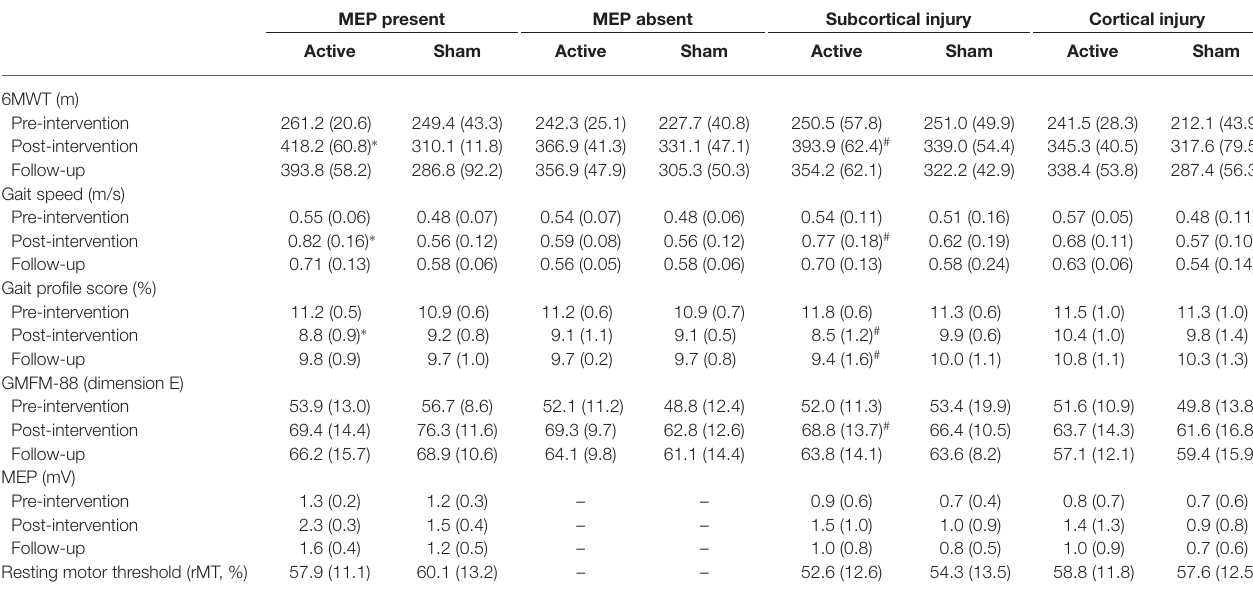
TABLE 3 | Mean and SD of results in children with presence and absence of MEP, and subcortical and cortical lesions considering active and sham tDCS. MEP present MEP